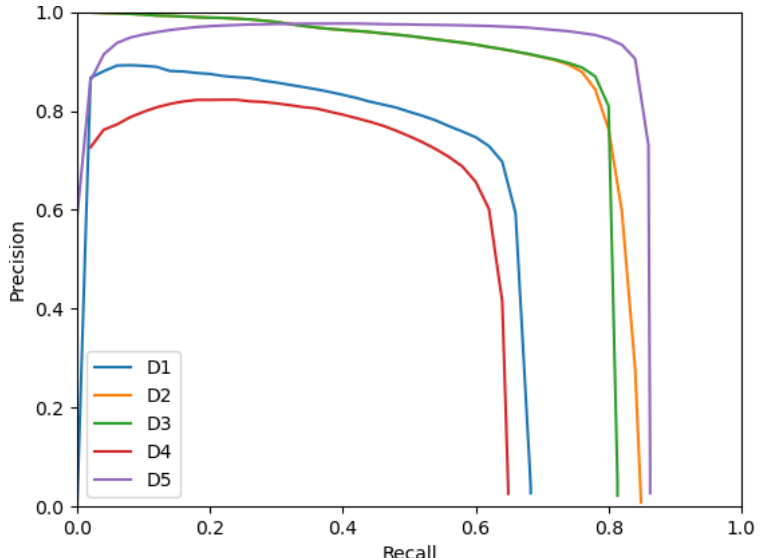
Figure 4. Precision–Recall curves for detectors with an IoU threshold of